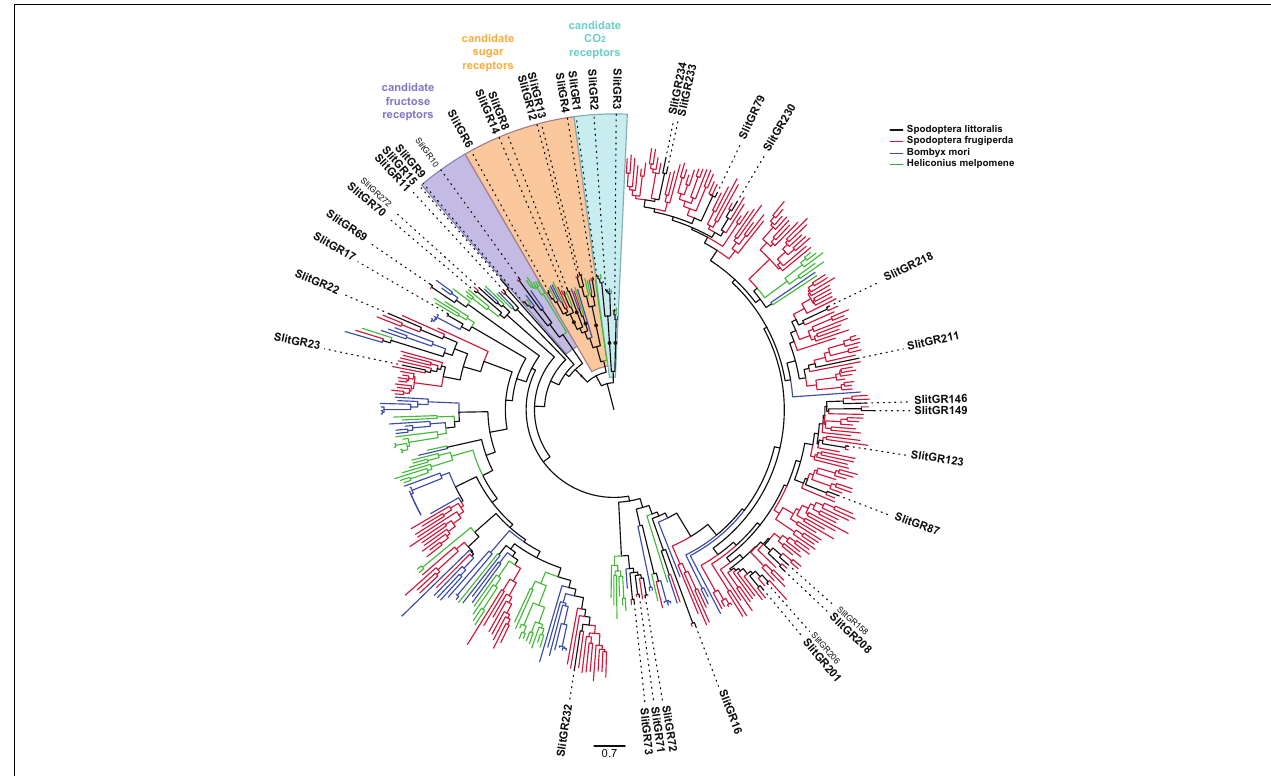
FIGURE 2 | Phylogenetic position of Spodoptera littoralis gustatory receptors (SlitGRX, black). The phylogeny was built using GR repertoires of the moths S. frugiperda (red) and Bombyx mori (blue), and the butterfly Heliconius melpomene (green). SlitGRs found in the present transcriptome are written in bold. Candidate CO 2 , sugar and fructose receptor clades are pictured with color shades. The CO 2 receptor clade was used as an outgroup. Clades supported by an aLRT value over 0.9 are indicated by a black